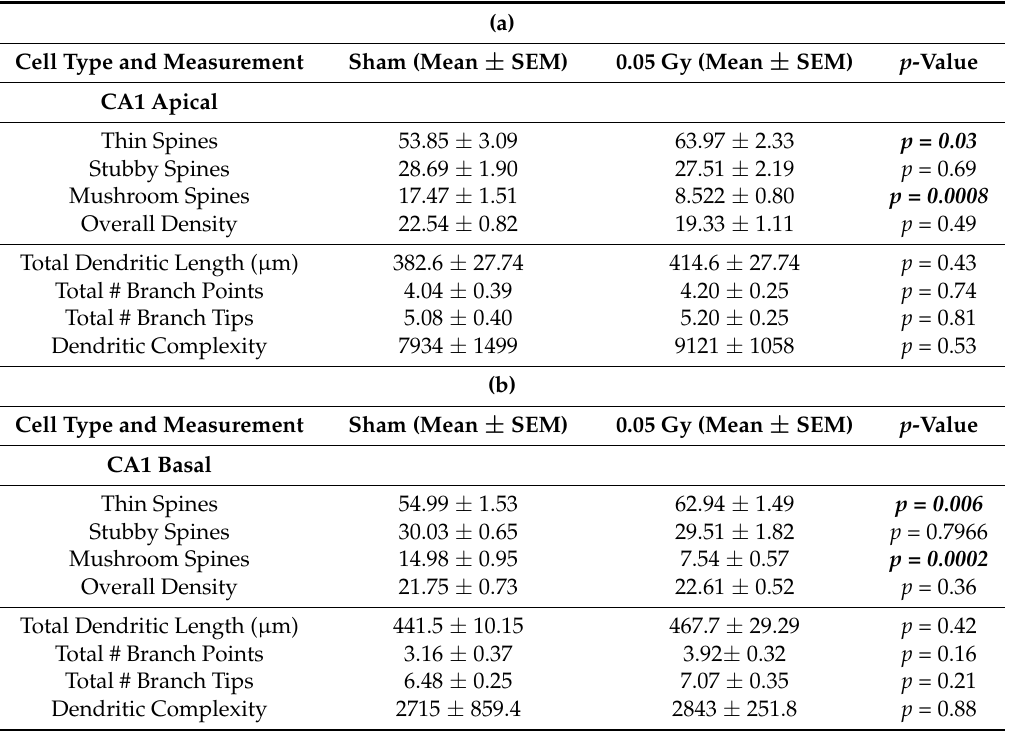
Table 2. Effects of 16 O on dendrite morphology in the